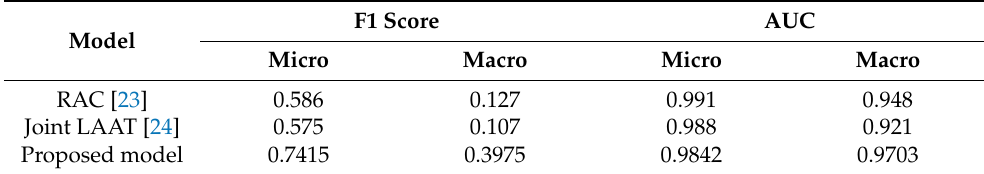
Table 7. Comparison with existing